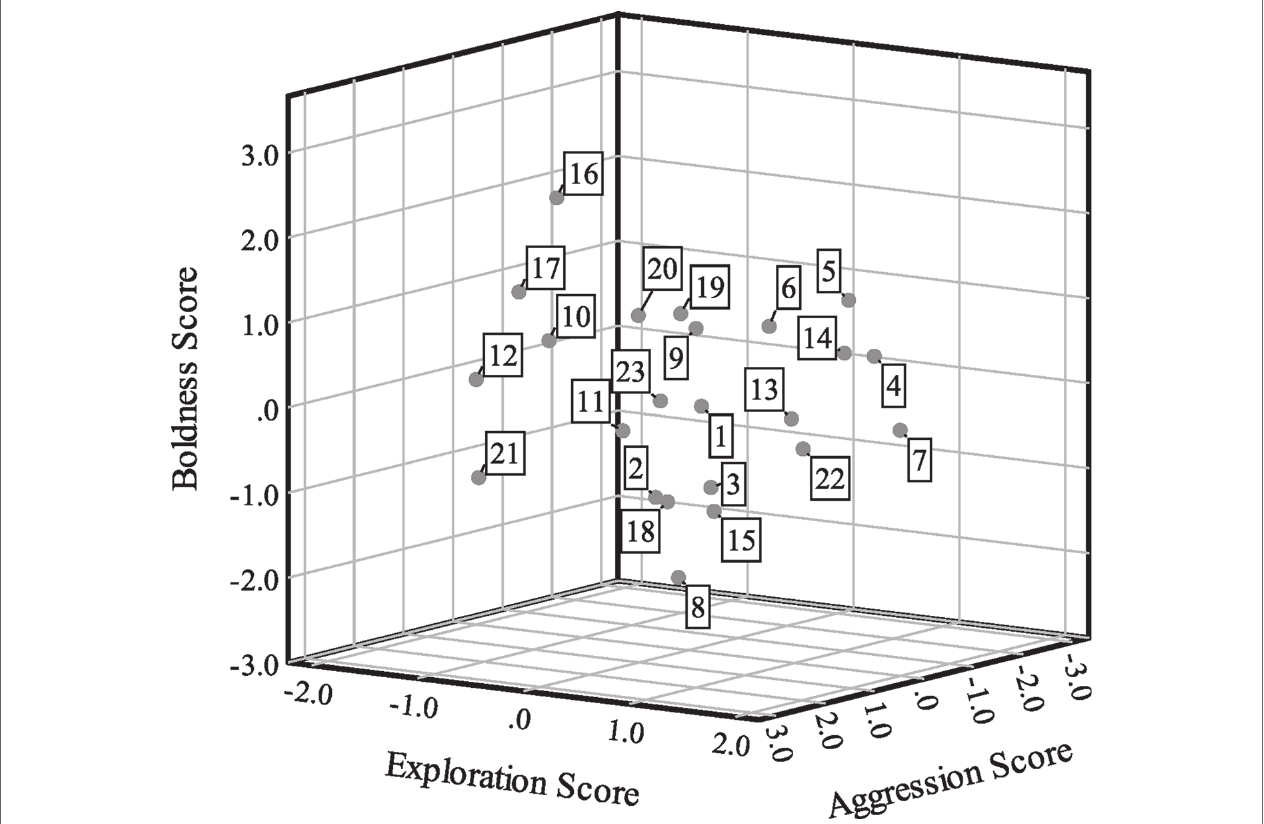
FIGURE 2 | Scatterplot of factor analysis scores showing exploration (factor 1) scores on the x-axis, boldness (factor 2) scores on the y-axis and aggression (factor 3) scores on the z-axis for n = 23 Blanding’s turtles. Cases are labeled by turtle